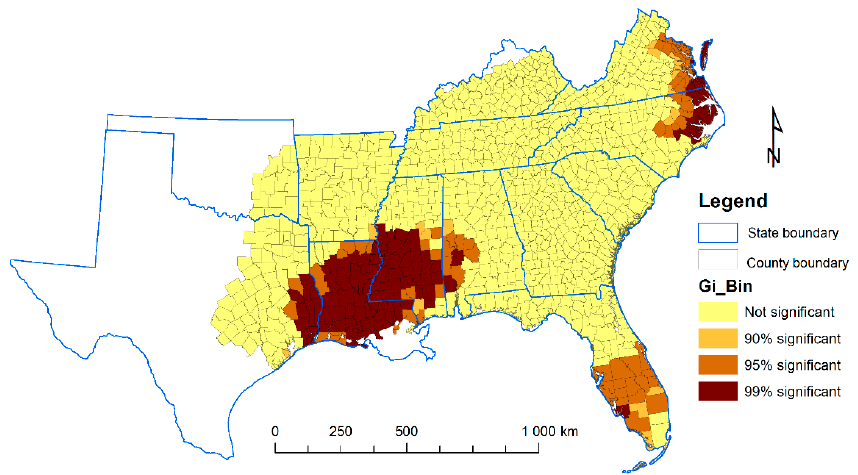
Figure 2. County level map showing hot spots of pine foliar disease based on binned Getis-Ord Gi